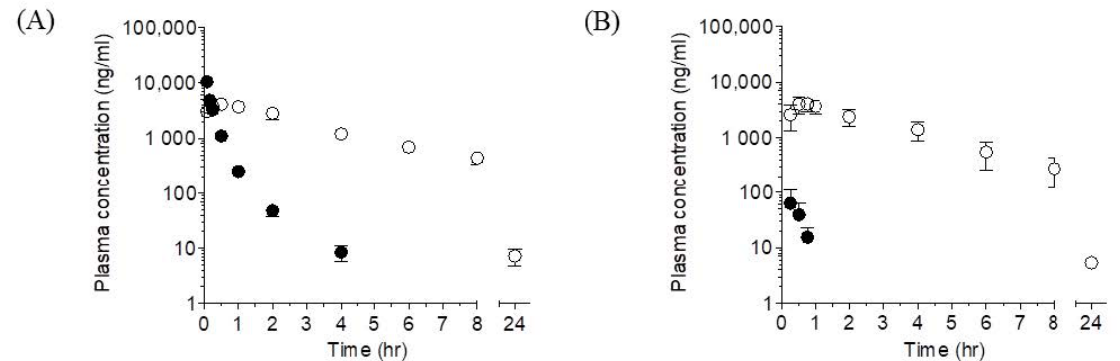
Figure 1. Plasma concentration-time profiles of LW6 and its metabolites following a single dose of LW6 in male ICR mice. A single dose of LW6 was given intravenously ( A ; 5 mg/kg; n = 4) or orally ( B ; 5 mg/kg; n = 5) and the plasma concentration of LW6 (●) and its metabolites, (4-adamantan-1-yl-phenoxy)acetic acid (APA) ( ○ ), was determined for 24 hr post-dosing. Each point represents mean ± S.D. ( n = 4~5).